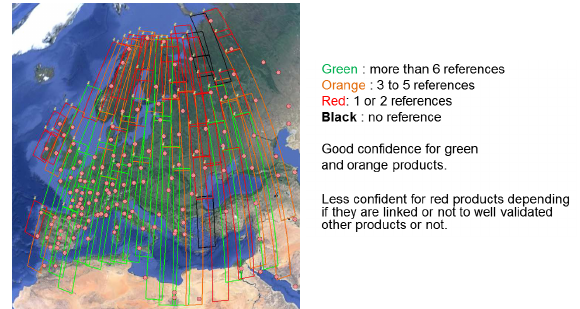
Figure 6. BDPHR number per European GRI products.